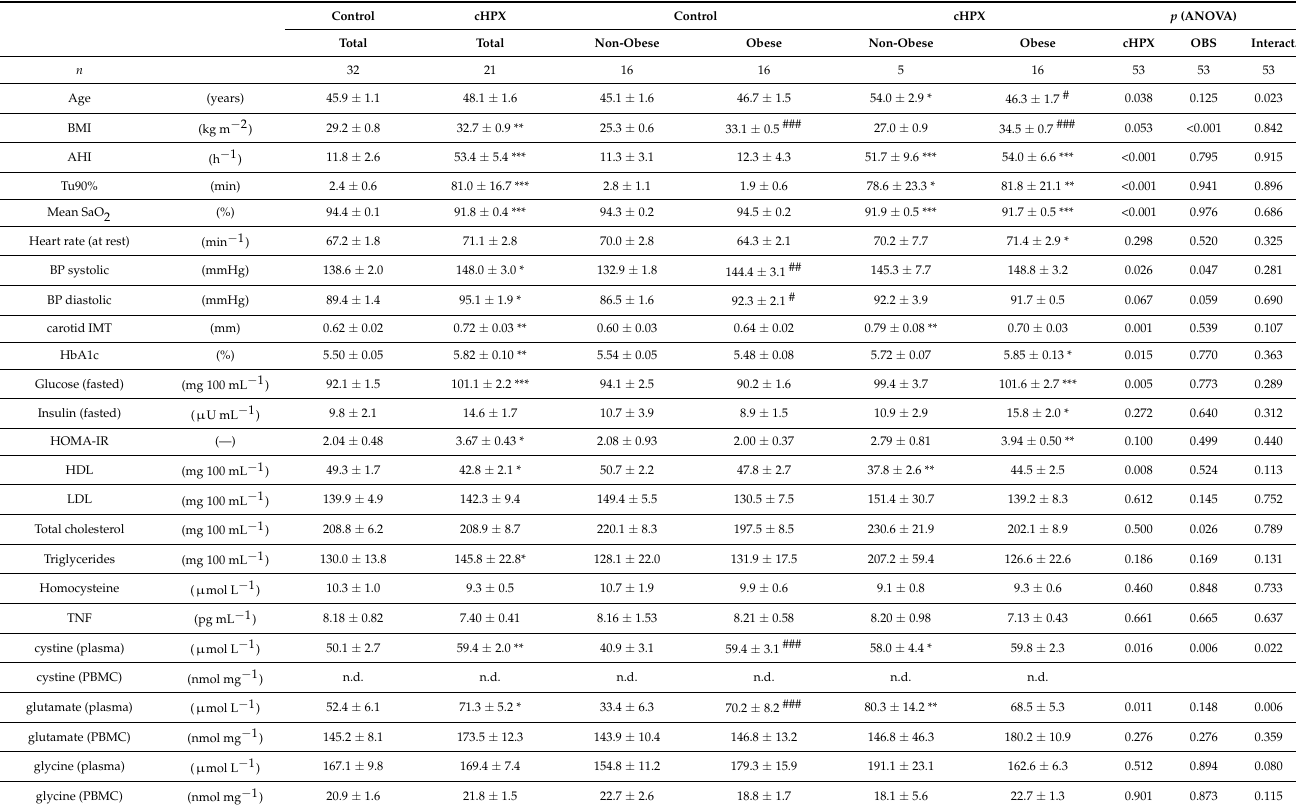
Table 2. Cross-sectional comparison between a group with cumulative hypoxic stress (cHPX, time at O 2 -saturation < 90% > 15.2 min) and controls with stratification for non-obese and obese BMI: Anthropometry, polysomnography, vascular risk factors, cystine, as well as glutamate and glycine.